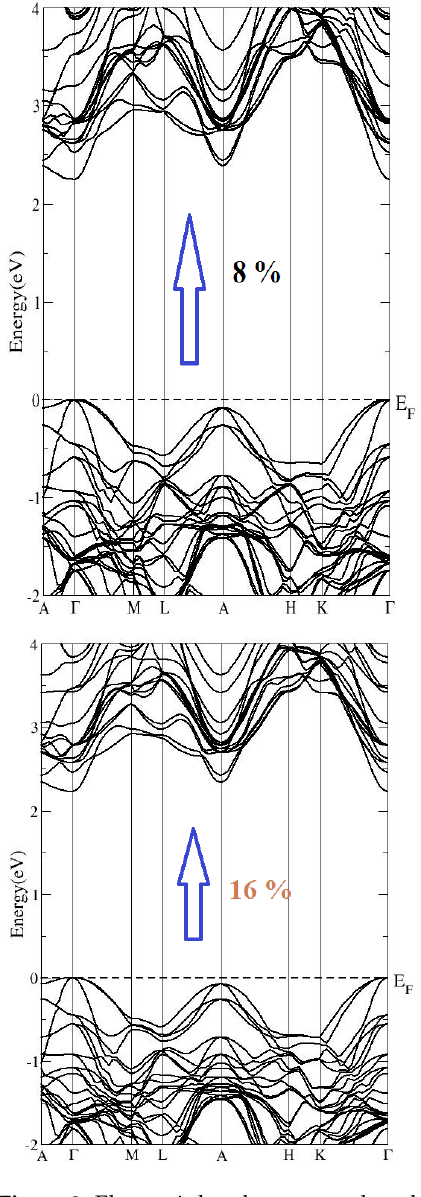
Figure 2. Electronic band structure along high symmetry points for Mn x Zn 1 − x Te (x = 8% and 16%).